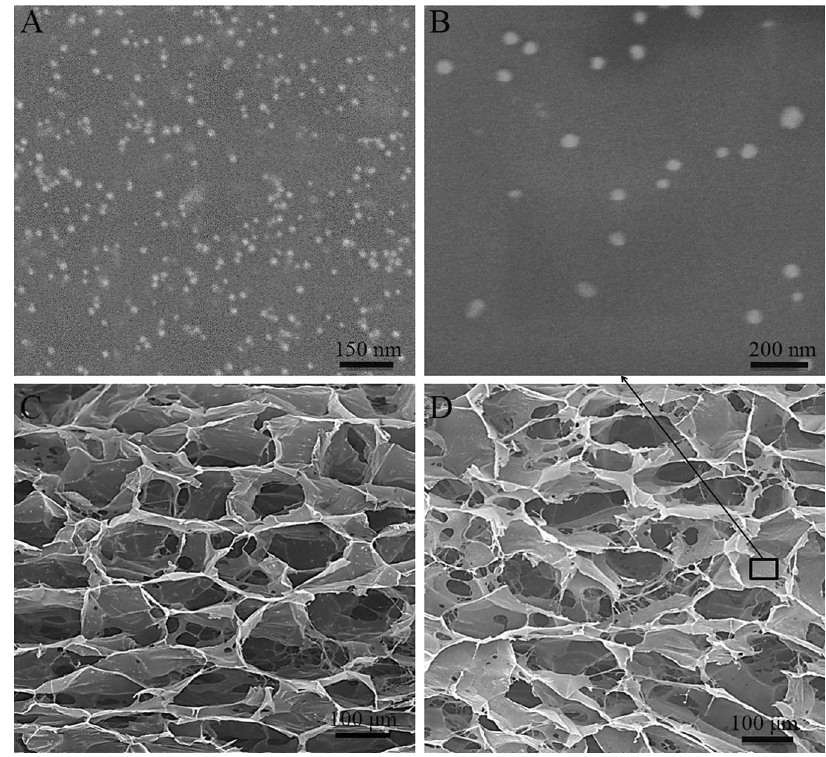
Figure 4. SEM images of NAg, CCS and NAg-CCS. ( A ) SEM images of NAg, ( B ) wrapped nanoparticles dispersed homogeneously in the CCS, ( C ) CCS, and ( D )